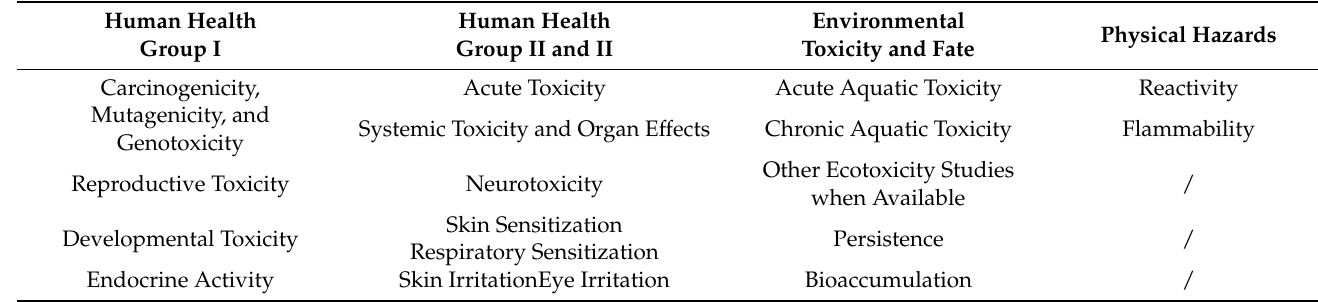
Table 3. Hazards considered in this project (modified from the criteria listed in the PHAROS project, https://pharosproject.net/). Human Health Group